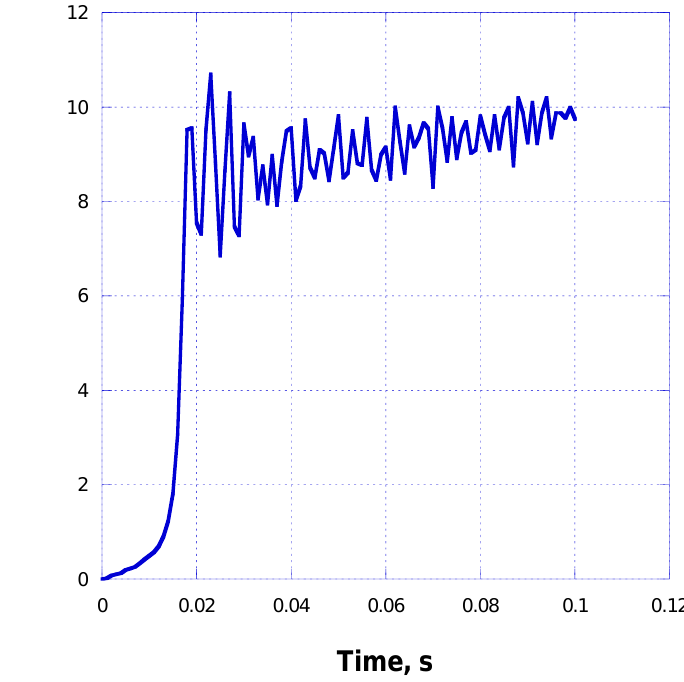
Figure 10. Displacement in characteristic B node in the present study.